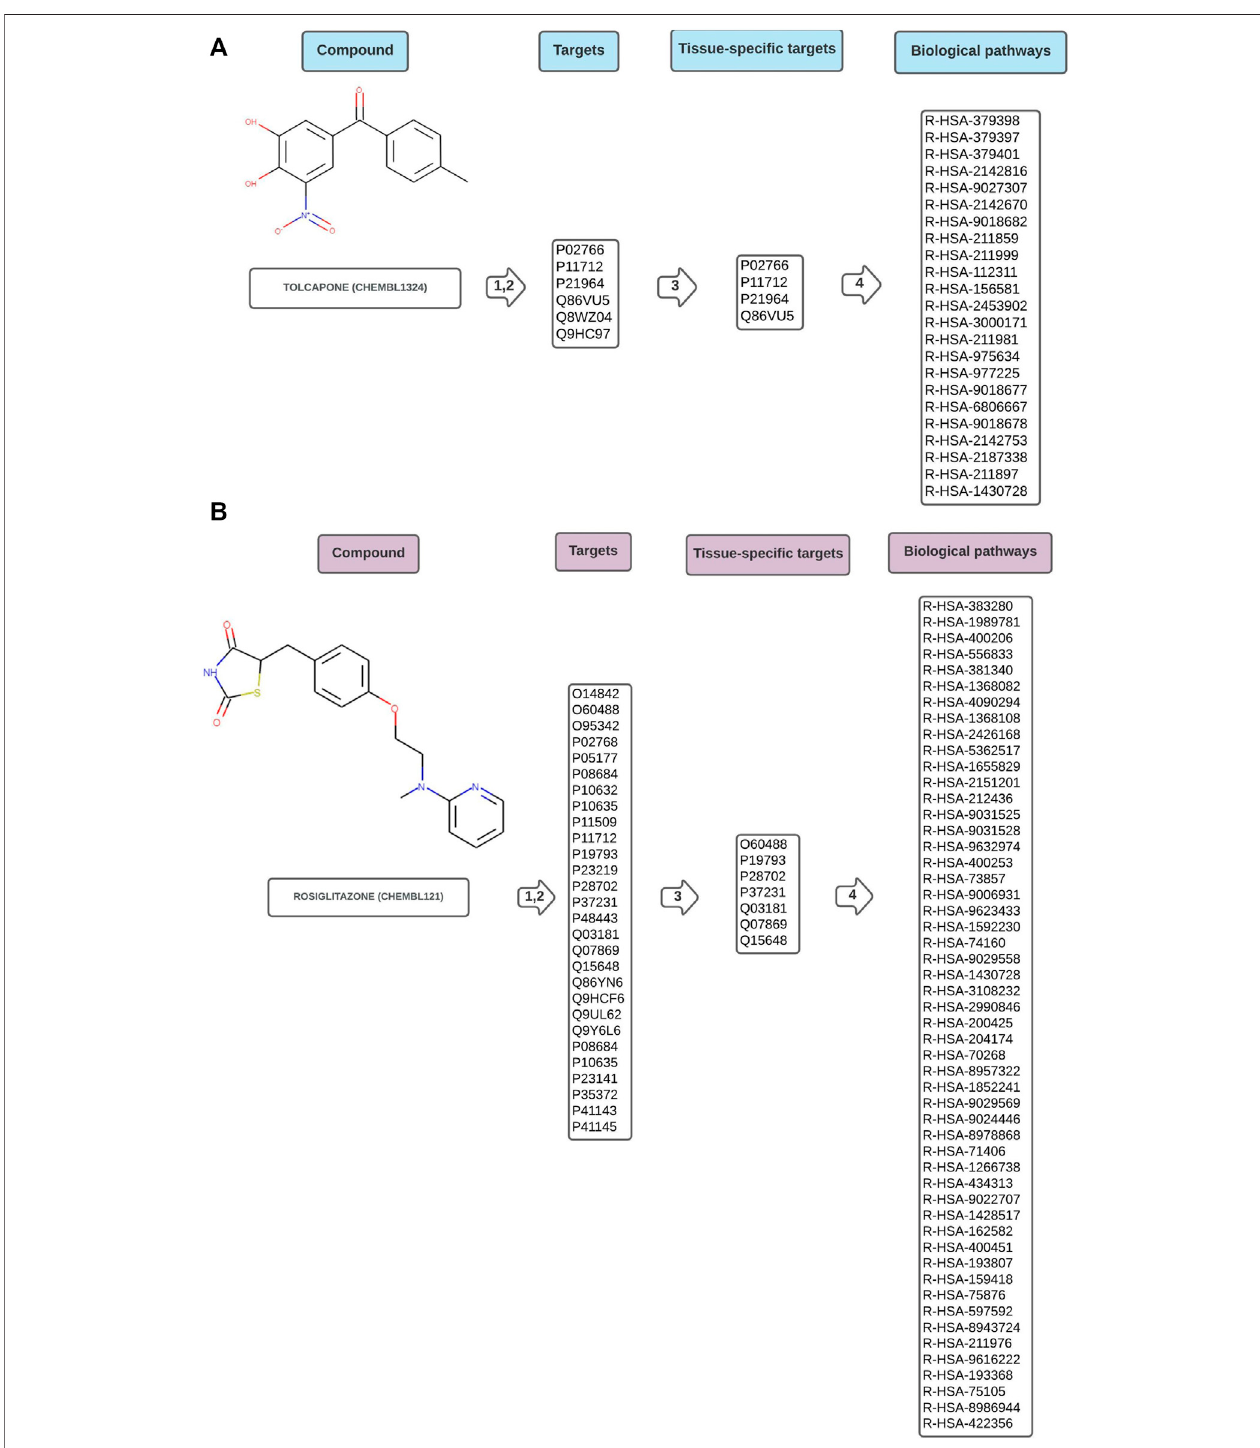
FIGURE 2 | Schematic representation of data fl ow in Path4Drug KNIME work fl ow for (A) hepatotoxic drug tolcapone (CHEMBL1234, https://www.ebi.ac.uk/ chembl/compound_report_card/CHEMBL1324/) and (B) cardiotoxic drug rosiglitazone (CHEMBL121, https://www.ebi.ac.uk/chembl/compound_report_card/ CHEMBL121/) with the harmonized target list represented by UniProt IDs, the tissue-speci fi c sub-list after fi ltering, and the biological pathways connected to the compoundsymbolizedbyReactomeIDs.Asdescribedinthemethodssection,instep1,2thetargetswereobtainedfrom fi vedifferentdatabasesandharmonized, in step 3 a tissue-speci fi c fi ltering was applied and in step 4 pathway overrepresentation test was performed using Reactome.